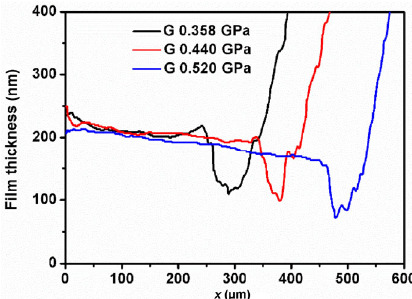
Fig. 16 Film thickness for urea-based grease under different loads ( u = 15 mm/s, straight line